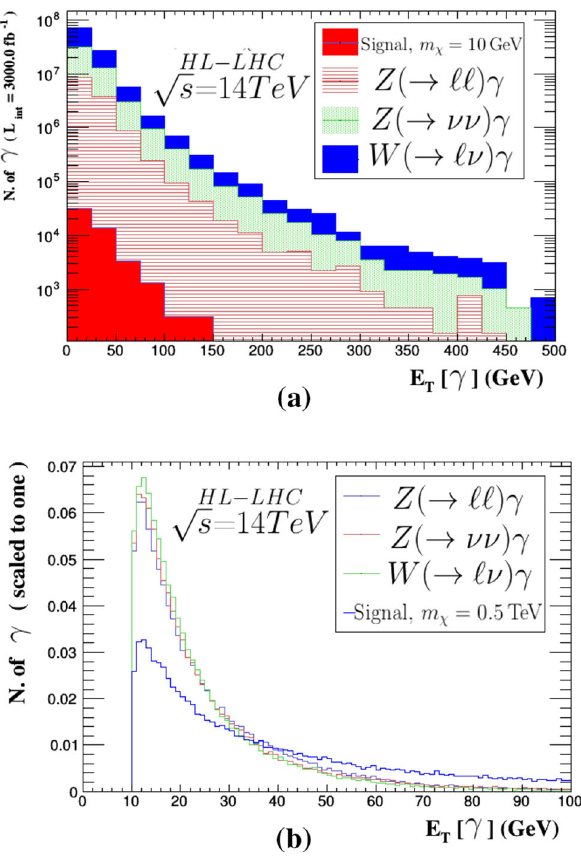
γ with no cuts for signal and main back- T